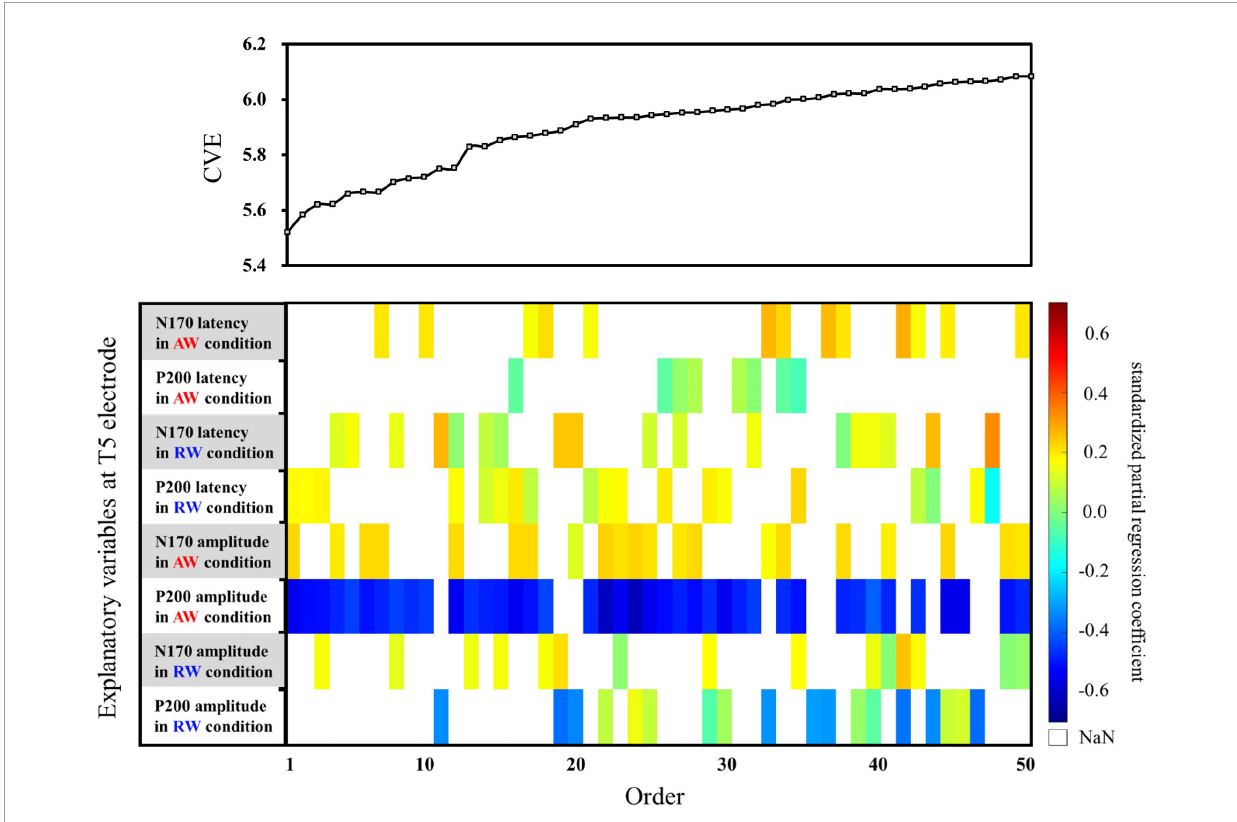
FIGURE4 Graph showing the values of the cross-validation errors (upper panel) and weight diagram plots (lower panel) for each model when performing multiple regression analysis with ES. The SATQ scores of each participant were designated as the objective variable and eight ERP indicators at electrodes T5 [(latencies and amplitudes) × (N170 and P200) × (in AW and RW conditions)] were the explanatory variables. Fifty of the 255 different regression models are arranged along the horizontal axis based on the model with the smallest CVE. The vertical axis presents the eight explanatory variables. The color map shows the value of the standardized partial regression coefficient for each explanatory function included in the model. The red/yellow spectrum indicates positive values, and the blue spectrum indicates negative values. White areas in the color map indicate that the explanatory variable is not included in the model. At the T5 electrode, “P200 amplitude in AW condition” (third row from the bottom) was the most frequently selected explanatory variable in 40 of the 50 models. The second most frequently selected variable was “N170 amplitude in the AW condition” (fourth row from the bottom), which was selected 21 times among the 50 models. AW, approaching walking movement; RW, receding walking movement; ST, standing; SATQ, subthreshold autism trait questionnaire; ERP, event-related potential; ES, exhaustive search.